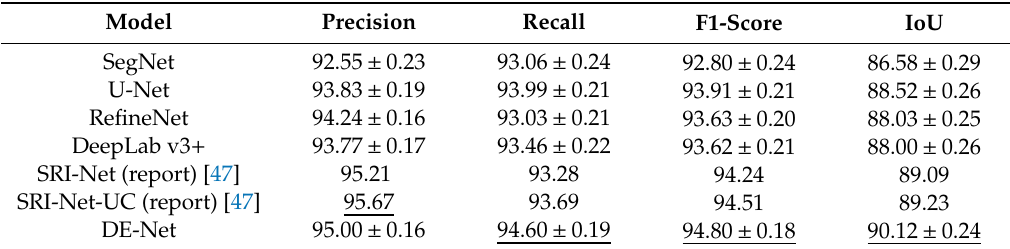
Table 1. Quantitative evaluation results on the testing set of the WHU Building dataset (WHU dataset) by di ff erent models in terms of precision (%), recall (%), F1-Score (%), and intersection over union (IoU) (%) (best values are